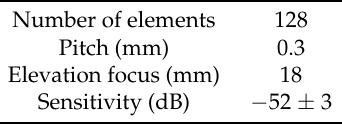
Table 3. Properties of the L 11 − 5 v Verasonics